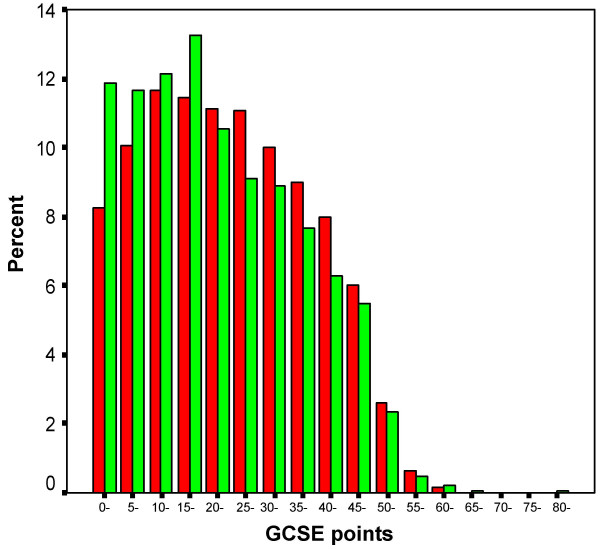
The distribution of GCSE points gained by W and NW students, shown in red and green respectively. GCSE points are group as 0–4, 5–9, 10–14, etc..